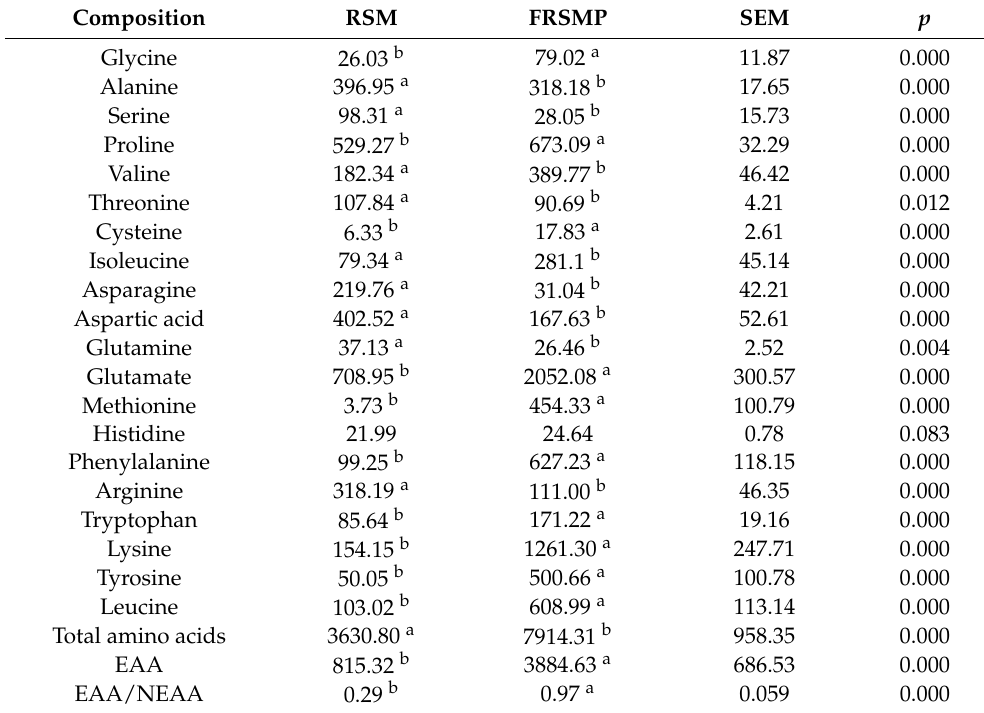
Table 3. Compositions and concentrations of free amino acids of the RSM and FRSMP (ng/g DM).